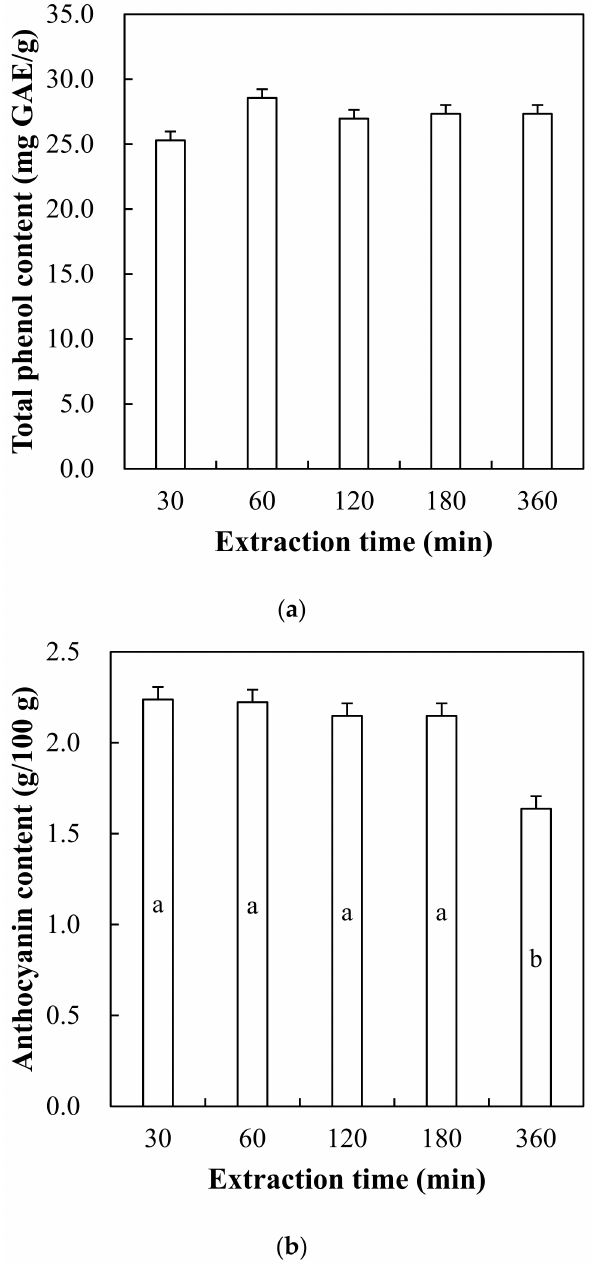
Figure 1. Total phenol content ( a ) and anthocyanin content ( b ) of red maple leaf extracts through hot water extraction (60 ◦ C) for 30, 60, 120, 180, and 360 min. Error bars represent standard error of the means. a,b Means with the same letter are not significantly different ( p ≥